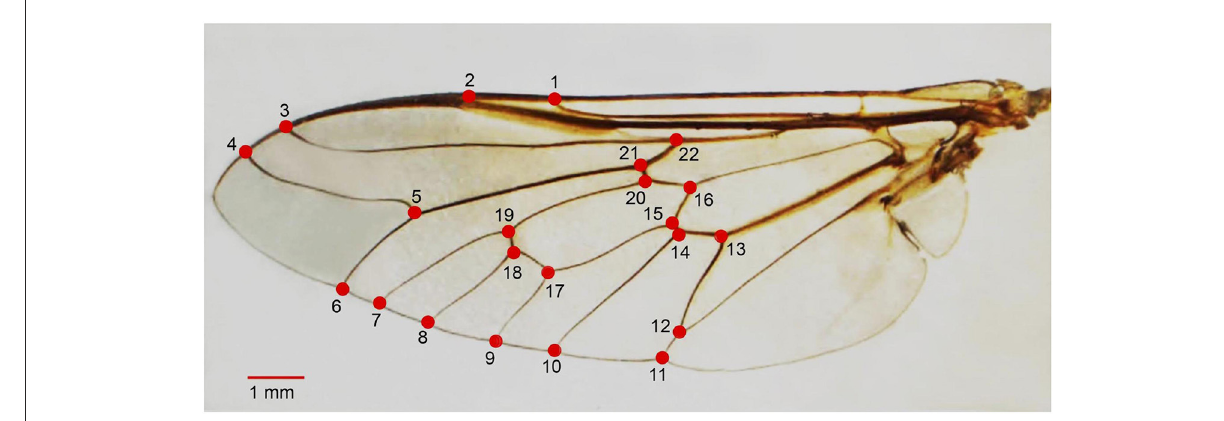
FIGURE2 Position of the 22 landmarks on the left wing of adult female Tabanus rubidus used for geometric morphometric analysis.